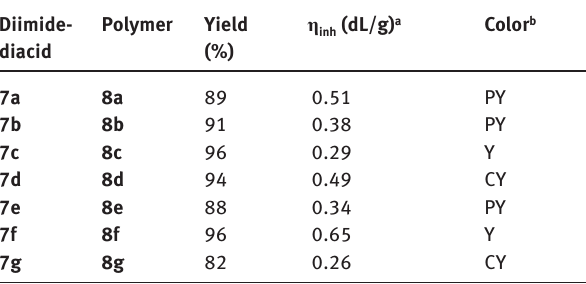
Table 2: Synthesis and some physical properties of PAIs 8a–g Diimide- diacid